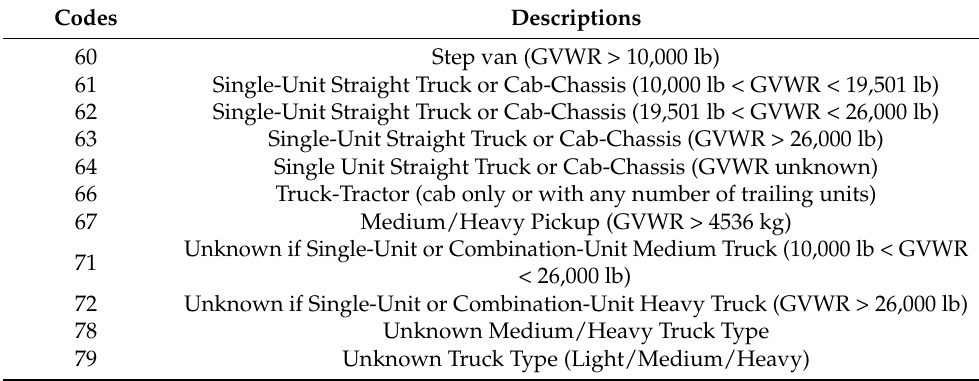
Table 1. Descriptions and codes for large trucks.